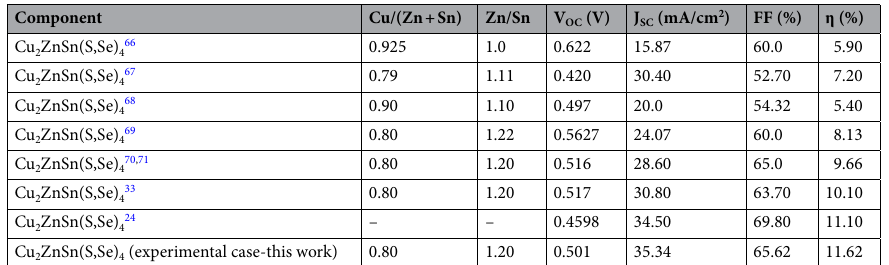
Table 2. reported performance parameters (V OC , J SC , FF, and η) of Cu 2 ZnSn(S,Se) 4 (CZTSSe) based solar cells with Cu/(Zn + Sn) and Zn/Sn ratios, which described as variable chemical